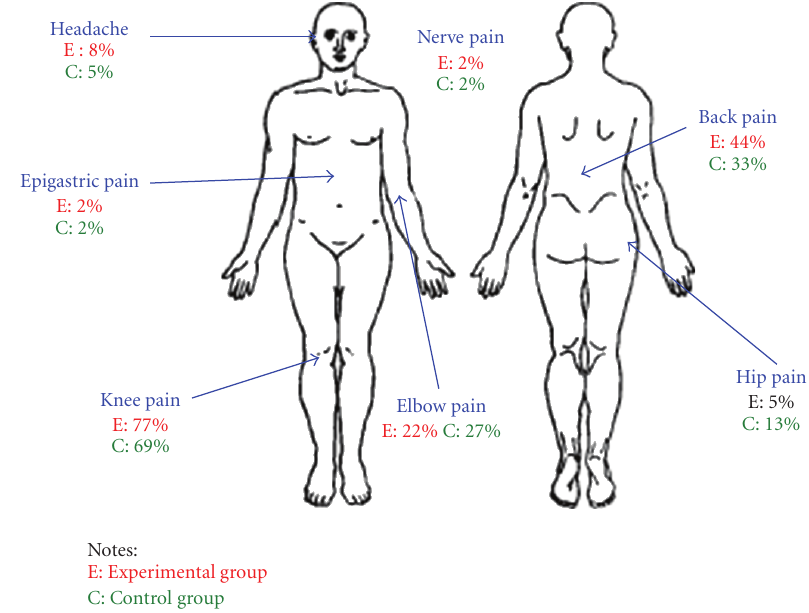
Figure 2: Location of pain.